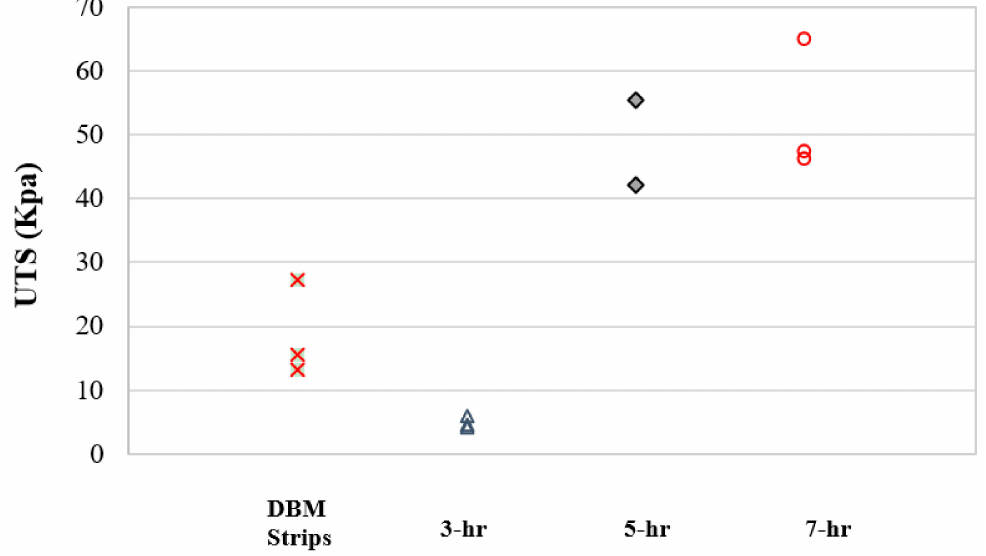
Figure 12. The comparison of the maximum tensile strength of the heat-treated samples to the demineralized cancellous bone grafts.